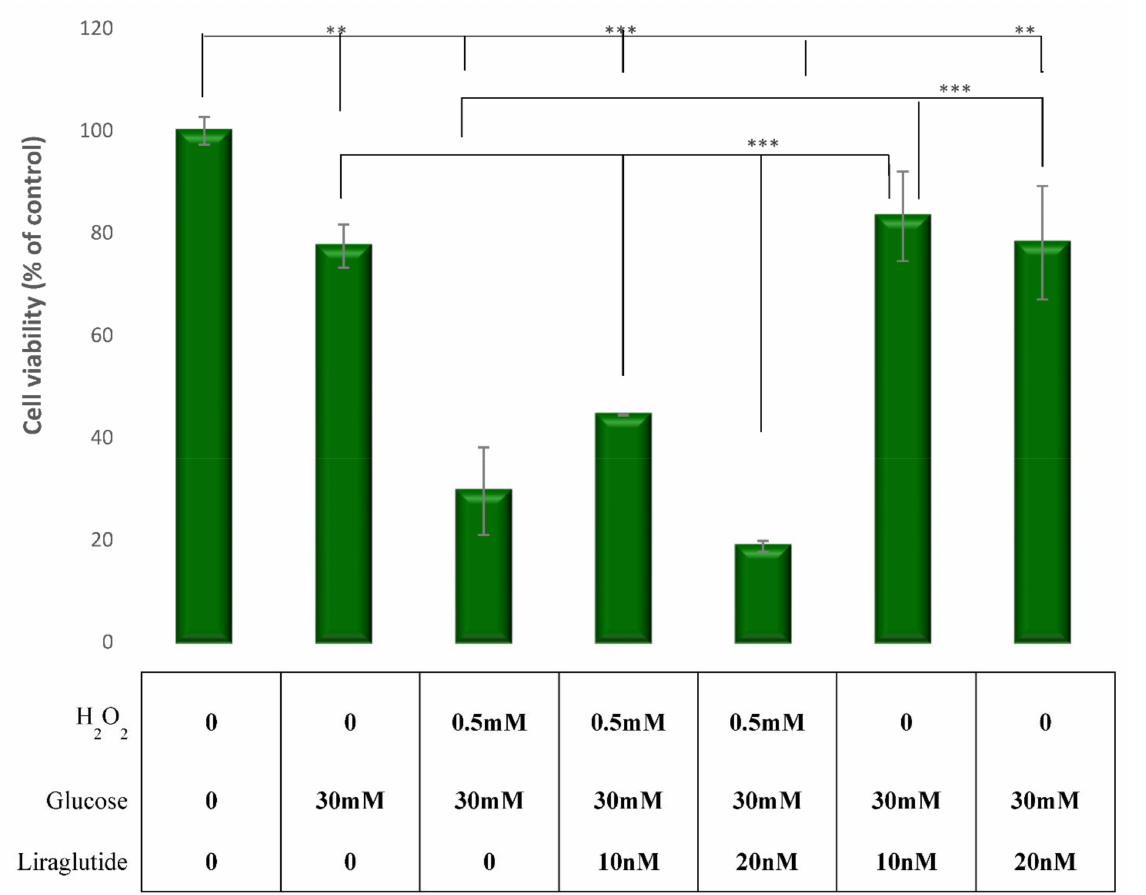
Figure 1. Cell viability assessed by an MTT assay in the experimental LLC-PK1-treated cell lines (control vs. HG30 and HG30/H 2 O 2 ; HG30 vs. HG30/Lira10 and HG30/Lira20; HG30/H 2 O 2 vs. HG30/H 2 O 2 /Lira10 and HG30/H 2 O 2 /Lira20). MTT measurements were done by spectrophotometry at 595 nm. One-way ANOVA F(8,44) = 67.66, p = 9.26 × 10 − 19 with Tukey HSD post hoc test; ** p < 0.01 *** p < 0.001. The data are shown as the means ± SD (standard deviation) from three independent biological replicates. Values underneath the x axis represent the amount of compound added in the experiment, and 0 represents that the compound was not added. MTT assay, pig proximal tubule cell line (LLC-PK1), HG (1.5 mM, 30 mM), H 2 O 2 (0.5 mM), Liraglutide (10 nM, 20